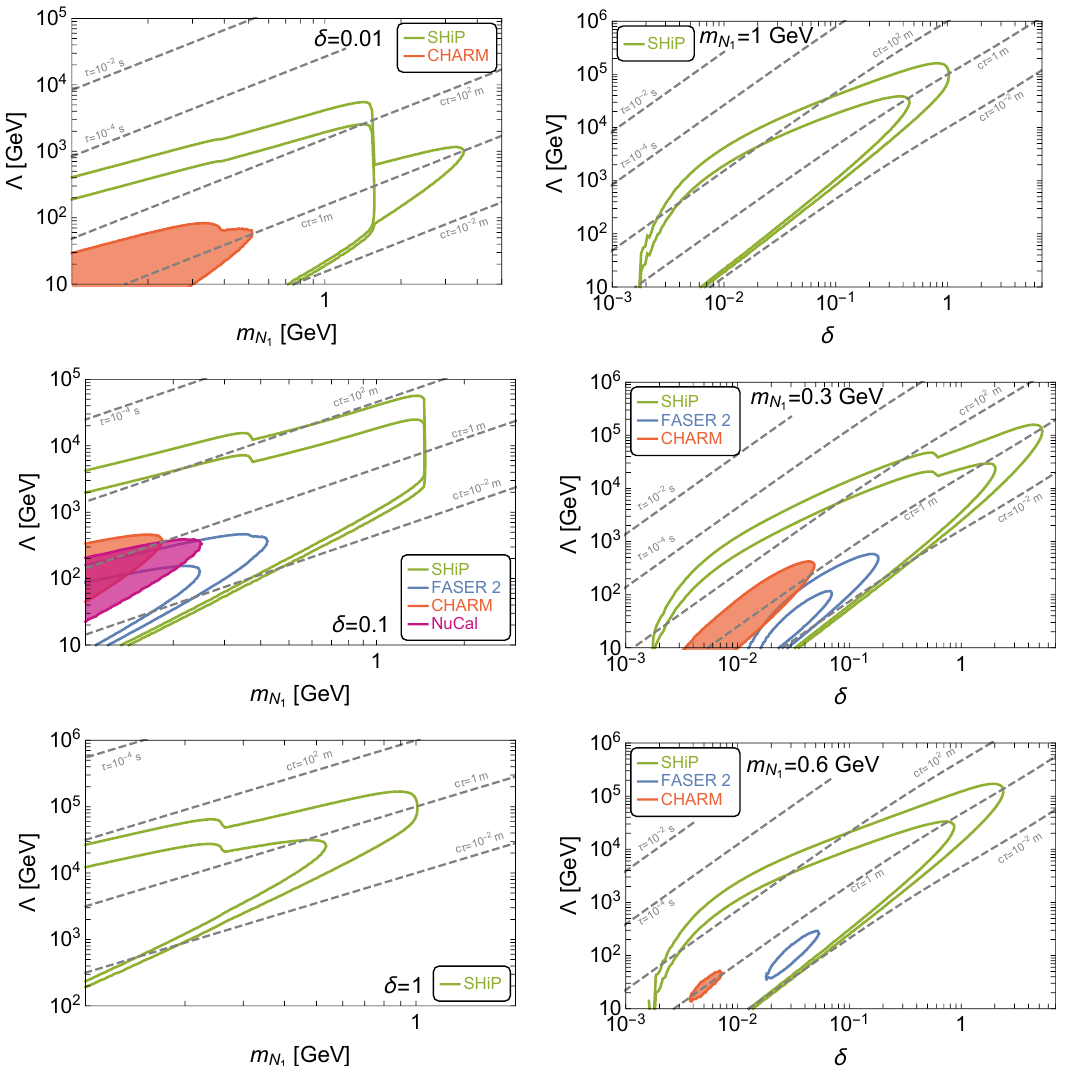
Figure 1 . Green and blue lines are the sensitivity reach of the SHiP and FASER 2 experiments. For SHiP we show isocontours of N = 3 and N = 63 . 8 . For FASER 2 we show isocontours signal signal of N = 3 and N = 63 . 8 , see section 3 for more details. The orange and magenta shaded signal signal regions are excluded by the CHARM and NuCal experiments. The dashed lines are contours of constant N lifetime or proper decay length. We fix α = π/ 2 2